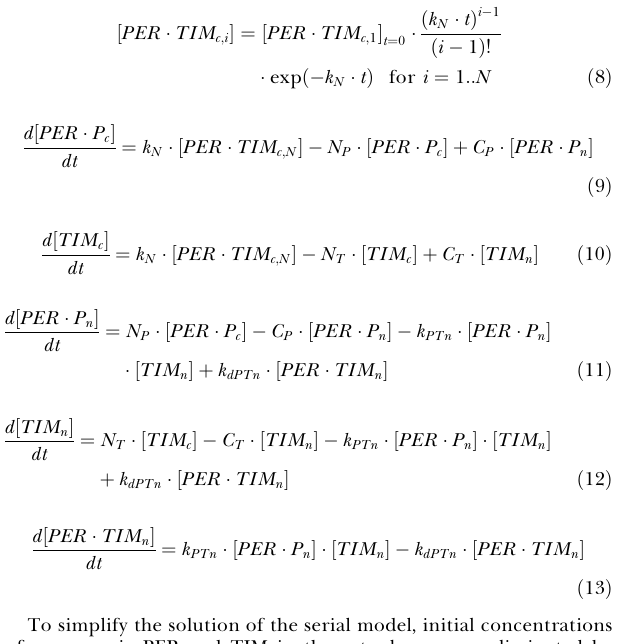
The per / tim loop of the detailed mathematical model of Drosophila circadian rhythmicity, a possible mechanism underlying the black box in Figure 1. Only one type of monomeric TIM and no monomeric DBT species were explicitly represented in the model. See Materials and Methods for a list of model equations.